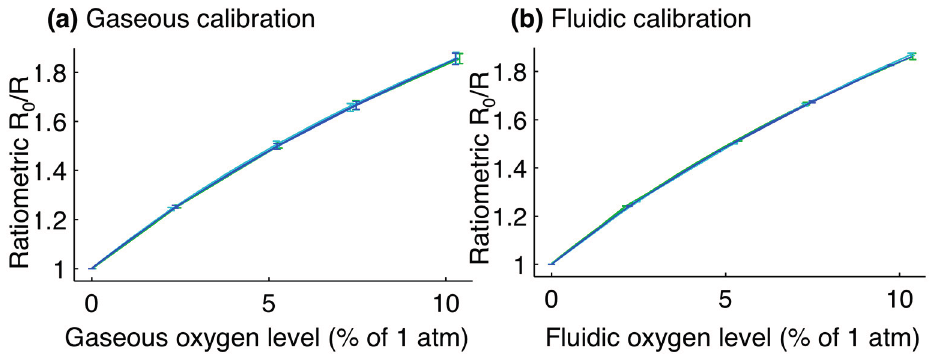
Figure 3. Calibration plots for optical oxygen sensors. ( a ) Gaseous calibration, with fit parameters of: k sv = 0.151% ± 0.004% atm − 1 ; f 1 = 0.756 ± 0.007; f 2 = 0.243 ± 0.007; ( b ) Fluidic calibration, with fit parameters of: k sv = 0.152% ± 0.006% atm − 1 ; f 1 = 0.755 ± 0.016; f 2 = 0.243 ± 0.015. For the fluidic calibration, the oxygen level is reported as the level of the gas in equilibrium with the liquid. Error bars represent the standard deviation in ratiometric intensity between four different sensor patches. Line colours represent the calibration curves for three different repetitions of the